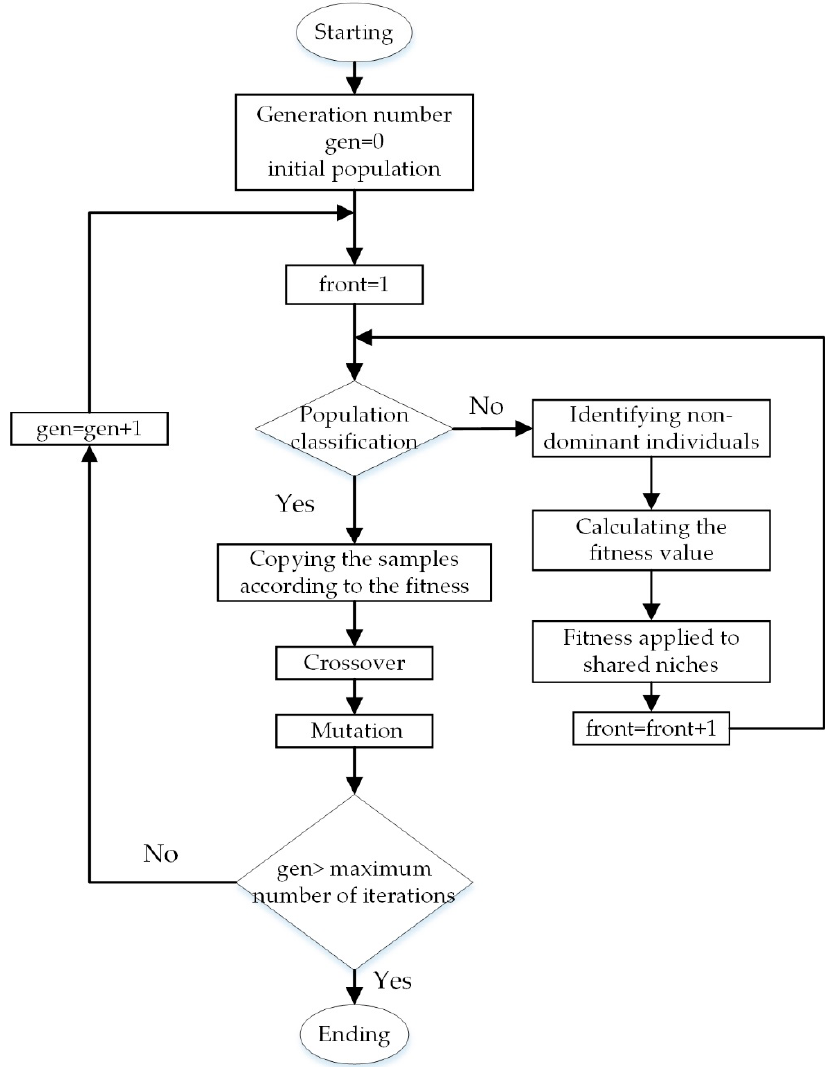
Figure 8. NSGA-II algorithm schematic.